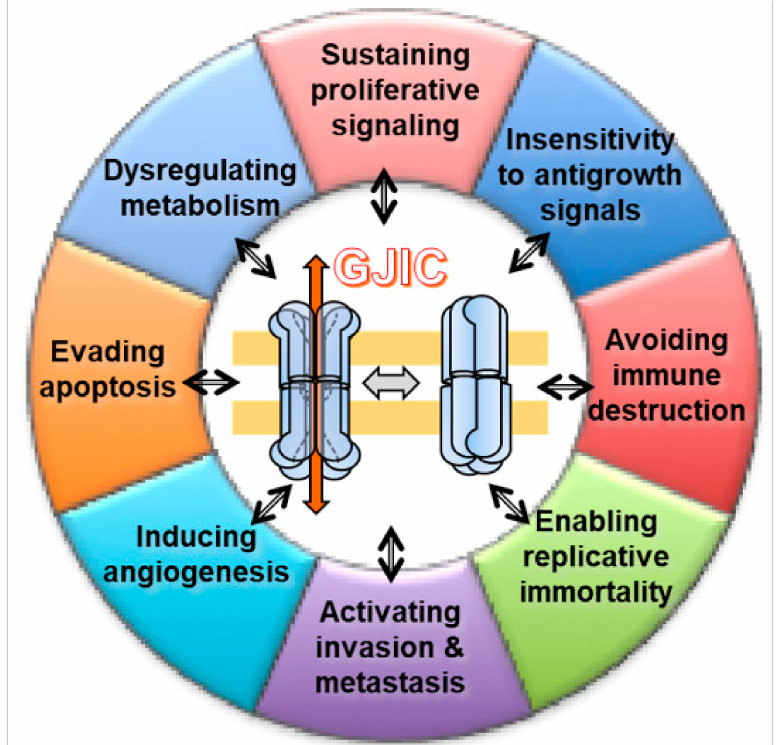
Figure 3. Schematic overview of the cancer hallmarks, as defined by Hanahan and Weinberg [66], and the involvement of GJIC in all of the hallmarks discussed in this